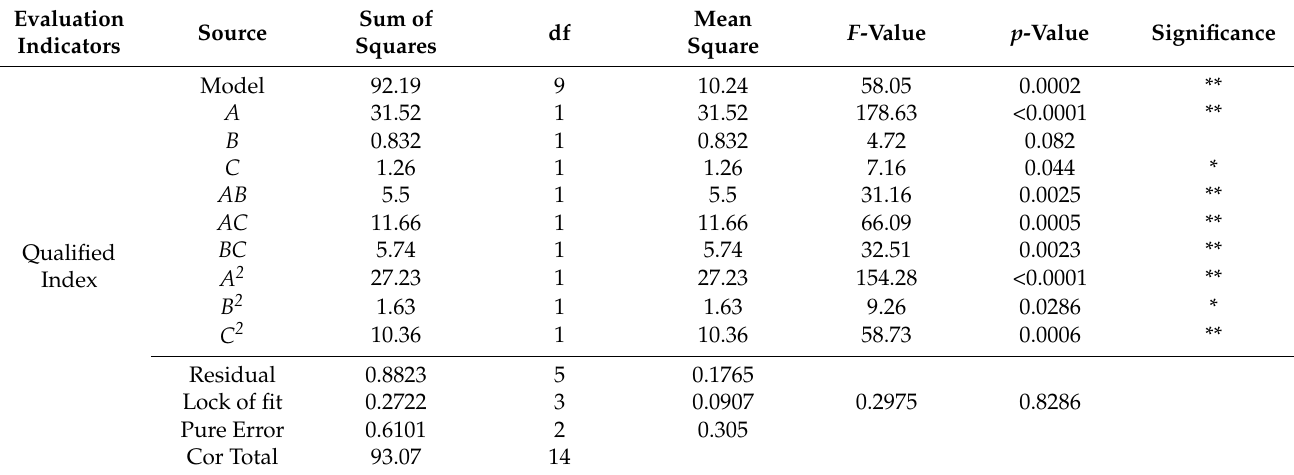
Table 4. Analysis of variance for the qualified